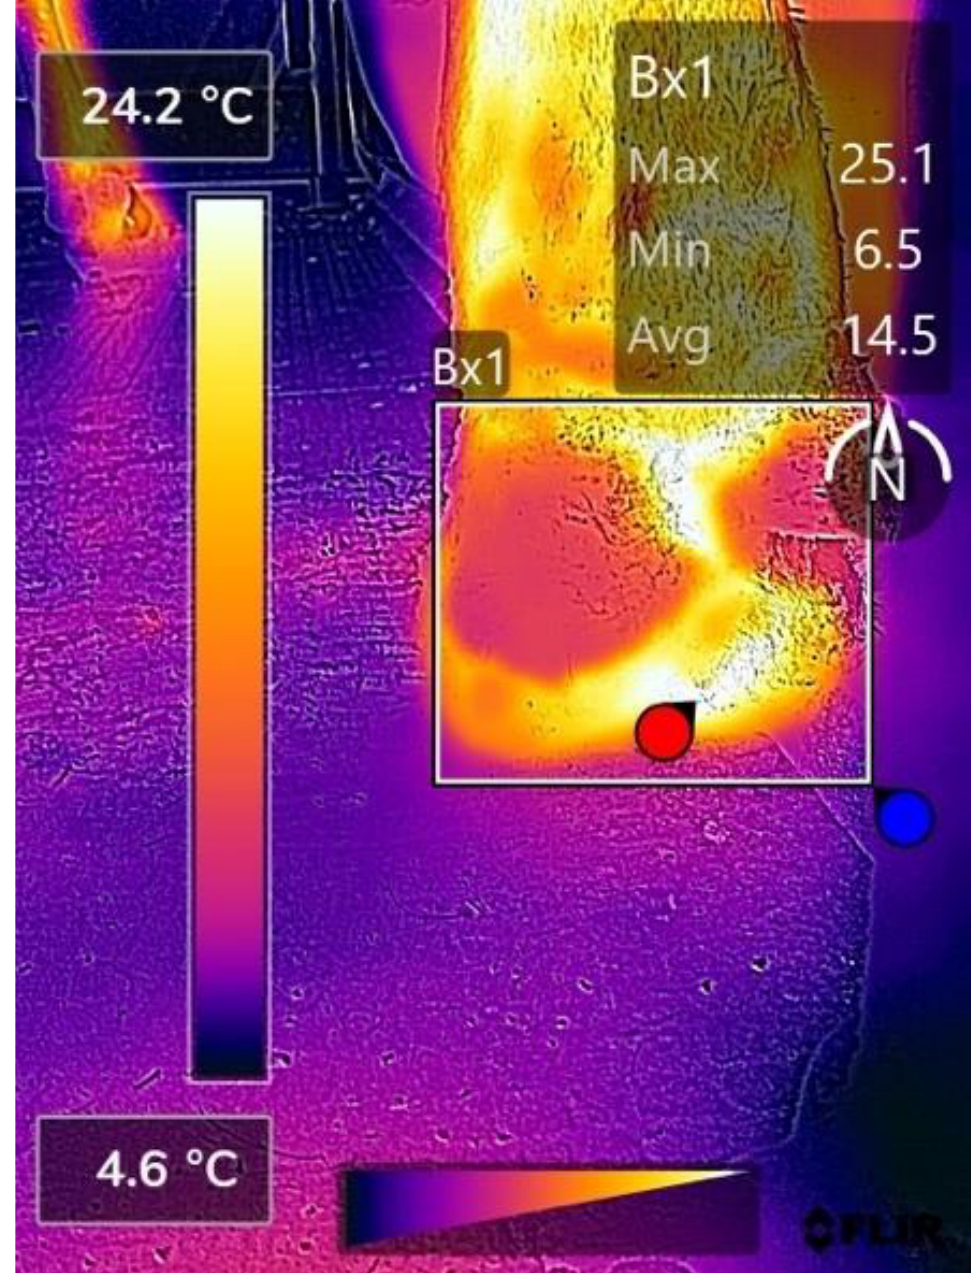
Figure A3. A thermogram, obtained by the CAT s62-Pro Smartphone (LCD), of cattle diagnosed with digital dermatitis on routine foot trimming, displaying a pattern of heat with maximum intensity over the interdigital space, rather than between the heel bulbs.